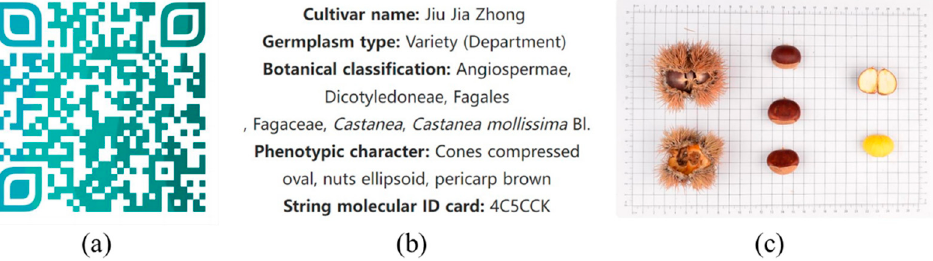
Figure 6. Example of QR code molecular ID card. ( a ) QR code molecular ID card of Chinese chestnut variety ‘Jiu Jia Zhong’; ( b , c ) display of the contents of the scan code.